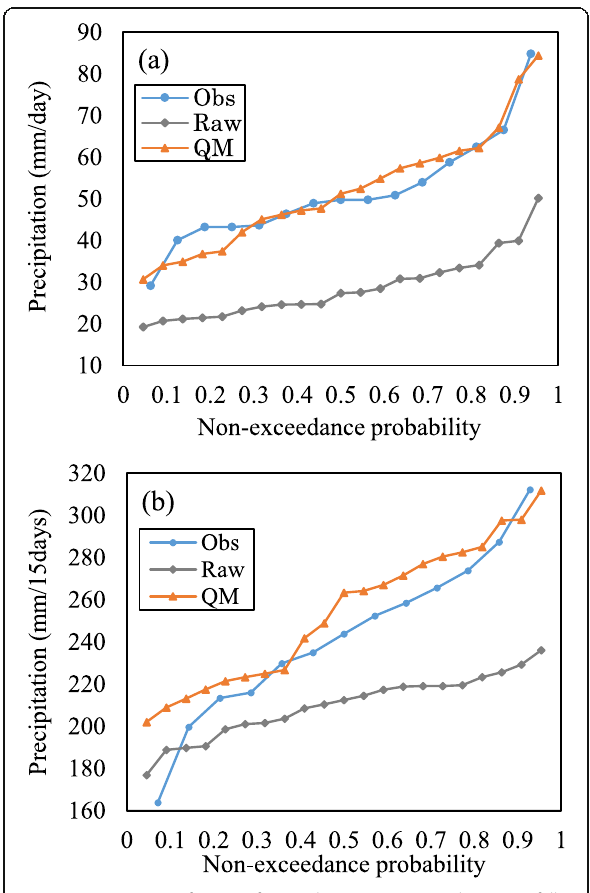
Fig. 4 Comparison of CDFs of annual maximum cumulative rainfall for different durations. a Daily and b 15-day rainfall of raw data, QM bias-corrected NHRCM and GSMaP